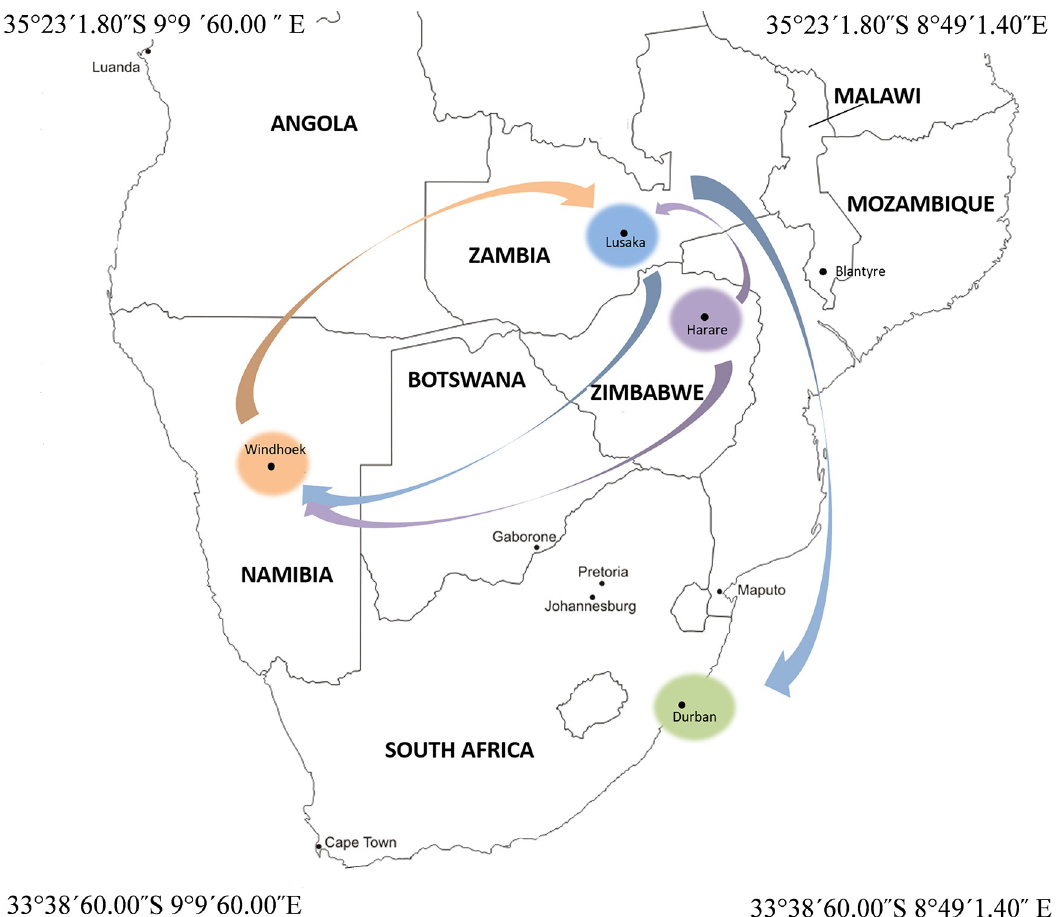
Fig 1. An illustration of city exchanges across southern Africa; Blue- Lusaka in Zambia, Purple- Harare in Zimbabwe, Orange- Windhoek in Namibia and Green- Durban in South Africa. The arrows indicate direction of exchange.